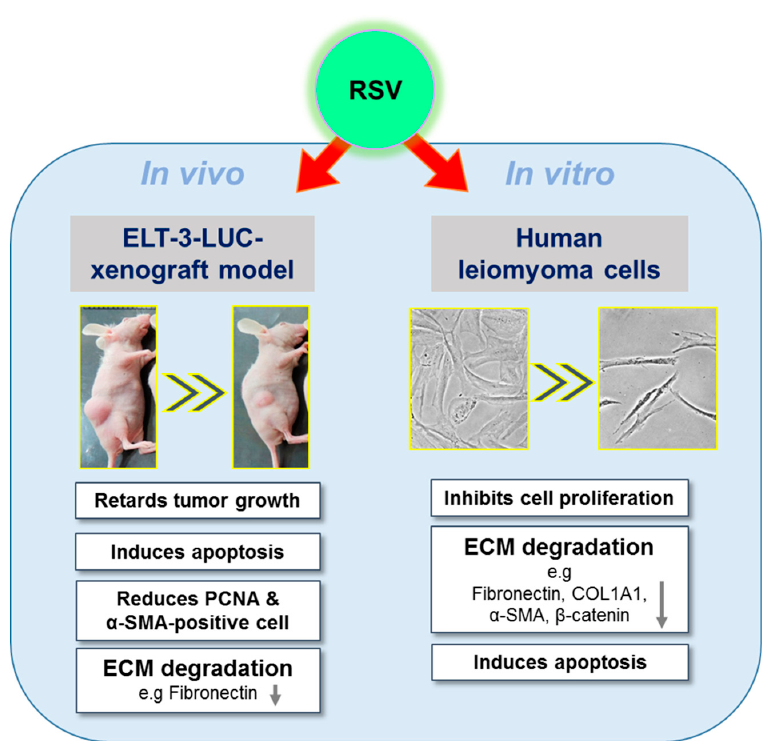
Figure 6. Schematic diagram of how the mechanism of RSV inhibits the growth of uterine fibroids. RSV significantly suppressed the tumor growth of ELT-3-LUC-xenografted mice and enhanced the Bax/Bcl-2 ratio, as well as reducing the proportion of PCNA and α -SMA-positive cells and the protein expression of fibronectin in an in vivo experiment. RSV also significantly inhibited the viability of primary human leiomyoma cells (magnification, ×200), induced apoptosis, and regulated the ECM-related gene (fibronectin) and proteins (COL1A1, vimentin, α -SMA, and β -catenin) in in vitro experiments. Abbreviations: RSV, resveratrol; ECM, extracellular matrix; PCNA, proliferating cell